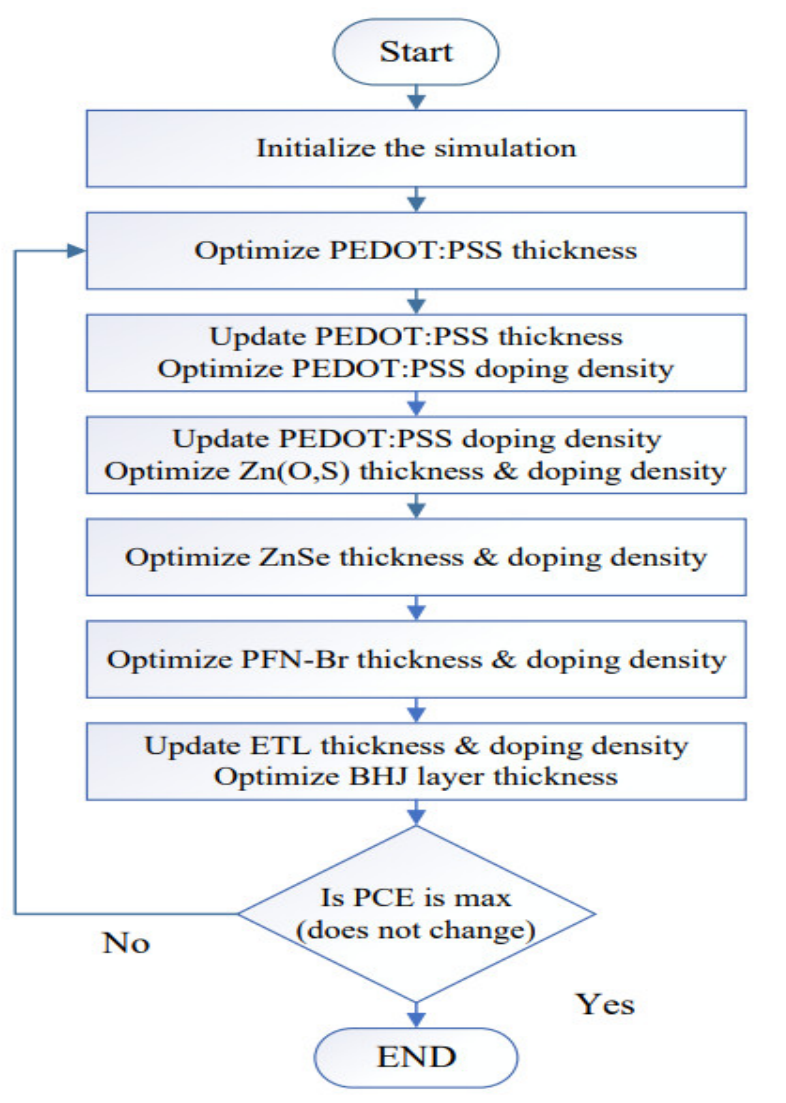
Figure 2. Shows the flow chart used to determine the maximum power-conversion efficiency of the proposed photovoltaic ITO/ETL/PTB7:PC 70 BM/PEDOT:PSS/Au devices with various ETL (Zn(O,S), ZnSe, and PFN-Br)